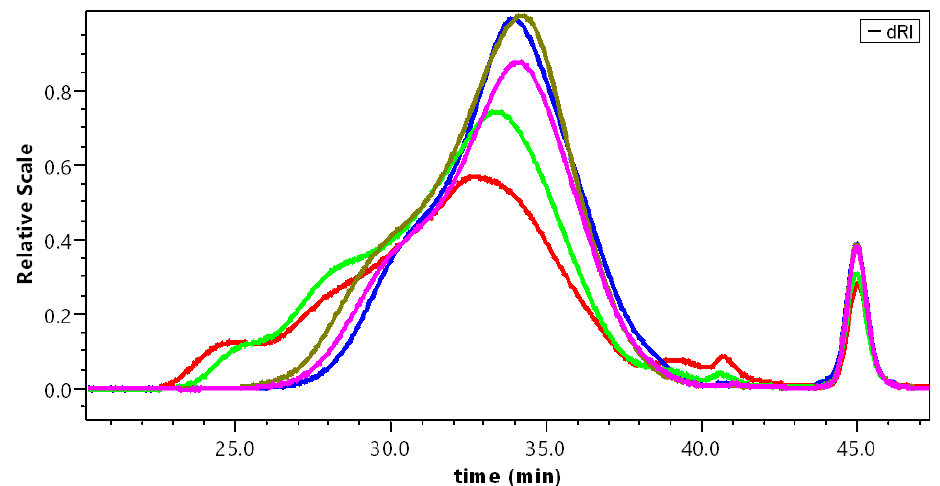
Figure 4. Chromatograms of the different pectins dissolved in 0.1 mol L − 1 NaNO 3 . APP (red); APP-A (green); APP-B (brown); APP-C (pink); and APP-E (blue).